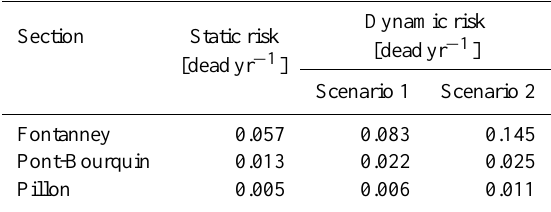
Table 6. Dynamic risk results of three scenarios on the road sections and static results of those sections (sum of both